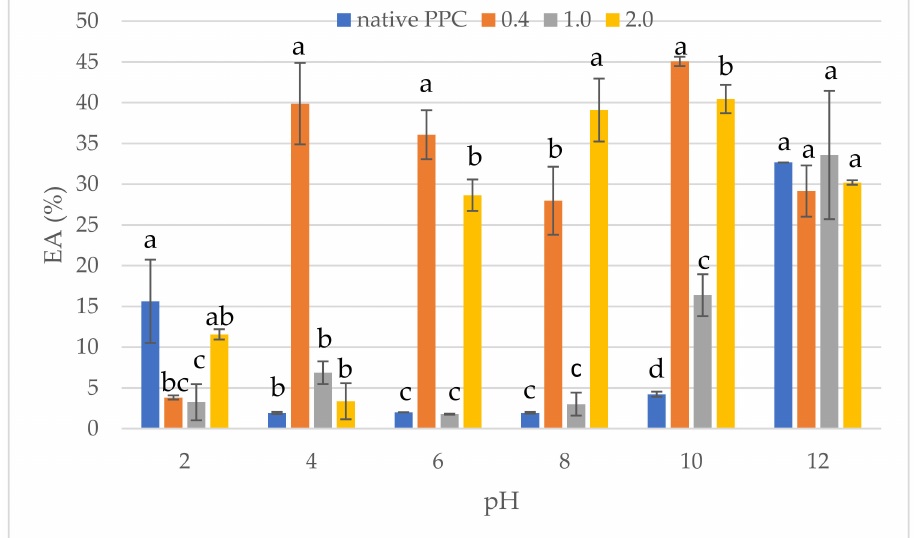
Figure 5. Effect of anhydride-to-protein ratio on emulsion activity (EA) at a different pH of native and acetylated PPC. a,b,c,d —the same letters within the same pH were not significantly different; PPC—pumpkin protein concentrate; 0.4, 1.0, 2.0—pumpkin protein preparations after acetylation conducted with different concentrations of acetic anhydride